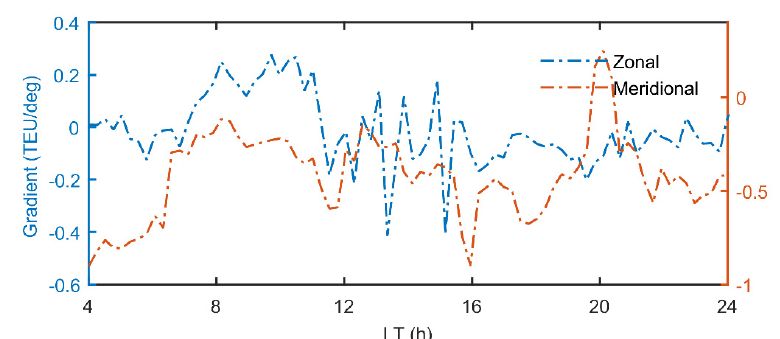
Figure 3. Local horizontal gradient derived from recursive method over GODZ station on 15 th January 2011.